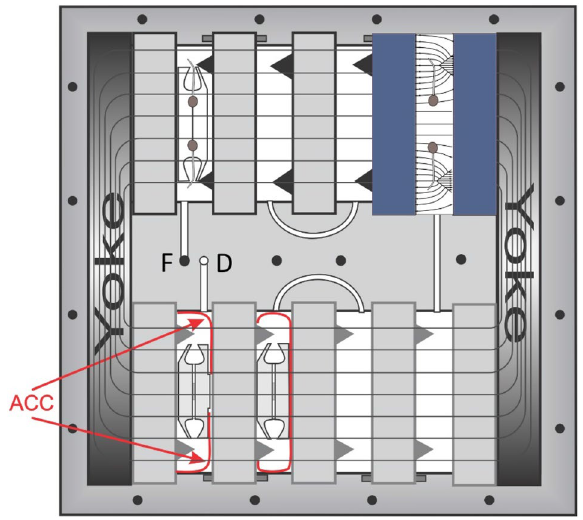
Figure 1. The design of the magnetic field chamber (MFC) with 10 magnets arranged in two stories with a total of eight compartments. The magnetic field was contained with two ferromagnetic yokes. Each compartment contained two ferromagnetic wedges and two pieces of activated charcoal cloth (ACC), and one seed cassette each. The diagram on the upper right shows the distortion of the magnetic field by the wedges (applicable to all compartments) and the projected growth of the seedling roots. The flow path of the fixative from a single fill port (F) to the drain port (D) is shown as white canals for front-visible paths; connections on the rear side between the individual compartments are shown as dark